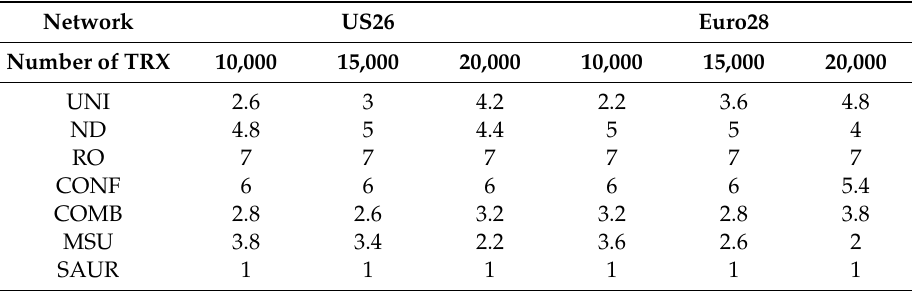
Table 3. Average ranking of algorithms for various number of